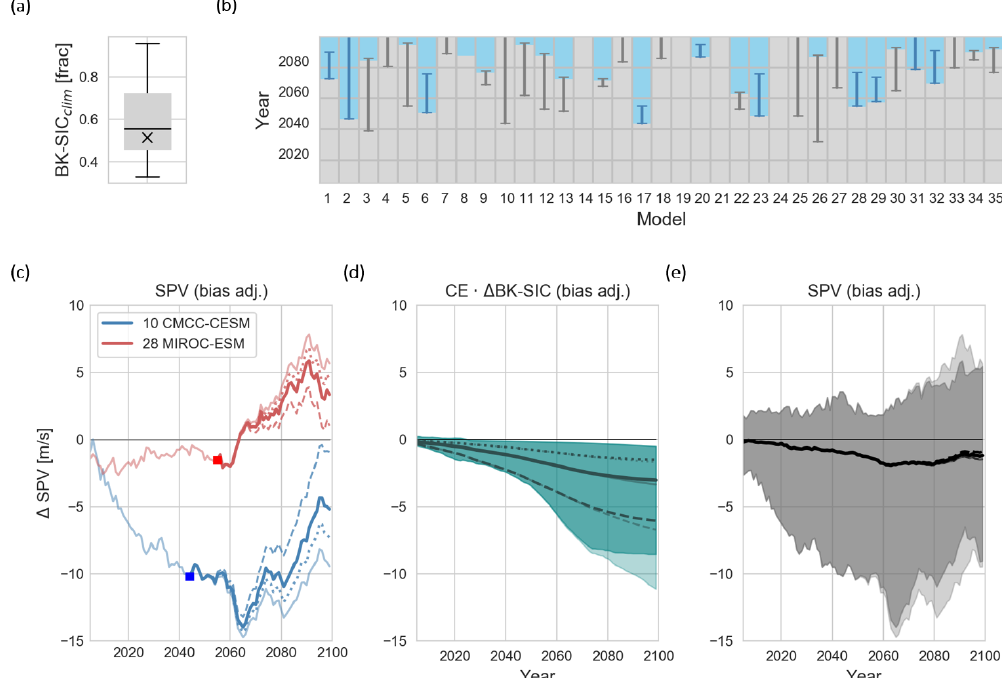
Figure 7. Bias-adjusted polar vortex change. (a) Spread across CMIP5 models of BK-SIC climatology (over 1960–1989 reference period). The black cross shows observational value, and the black line indicates the ensemble median. (b) Grey shading indicates years when BK seas are still ice covered, and blue shading indicates years after the BK seas have become ice-free (see methods). Vertical lines indicate the period over which the bias-adjustment function ramps either up or down, and grey indicates models with too much ice and blue models with too little ice. (c) Bias adjustment when assuming ce = 0.05 (thick lines) for models 10 and 28. Light thin lines indicate the actual projected change, while dashed lines indicate bias adjustment when assuming a causal effect of ce = 0.1 and dotted lines for ce = 0.025. (d) Spread of predicted SPV from BK-SIC (light shading) and of bias-adjusted BK-SIC for ce = 0.05 (dark shading). The dashed and dotted lines show the ensemble mean values for a causal effect of 0.1 and 0.025, respectively. (e) Same as (d) but for projected SPV and for visualization reasons not showing the values for ce =